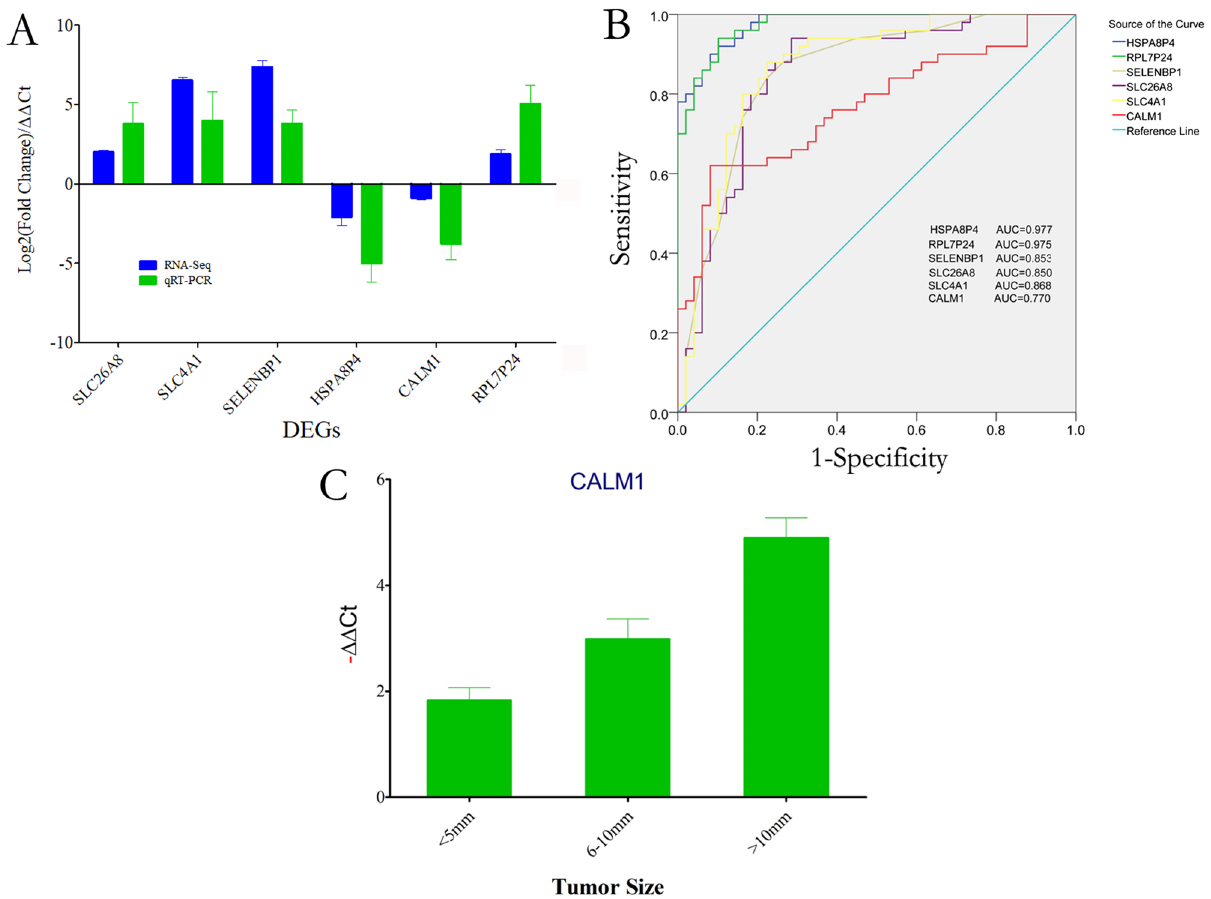
SPSS version 22.0, https:// www. ibm. com/ cn- zh/ analy tics/ spss- stati stics- softw are. ( A ) In 33 HCC patients with 32 normal controls, expressions of selected dysregulated genes were assessed employing qRT-PCR in specimens from HCC samples. ( B ) ROC curve analysis of SELENBP1, SLC4A1, SLC26A8, HSPA8P4, CALM1, and RPL7p24, AUC values are given on the graphs. ( C ) Relationship of CALM1 gene expression and tumor sizes, the gene decreased gradually when tumor